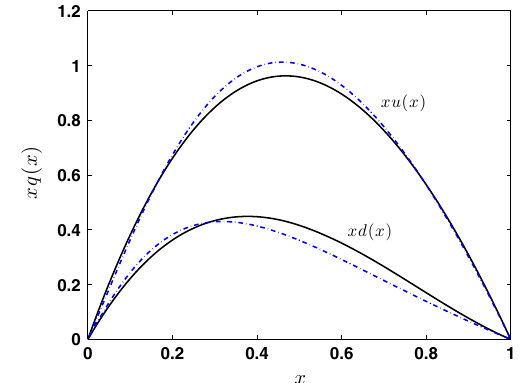
Fig. 2 The distributions xu ( x ) and xd ( x ) as a function of x . From the soft-wall linear potential ( solid lines ) and from the IR-improved potential model ( dot-dashed ), when higher-Fock states are included (cf. Sect. 3.2). The total momentum sum rule reads M u + d = 0 . 92 for the SW model, M u + d = 0 . 91 for the IR when higher Fock states are